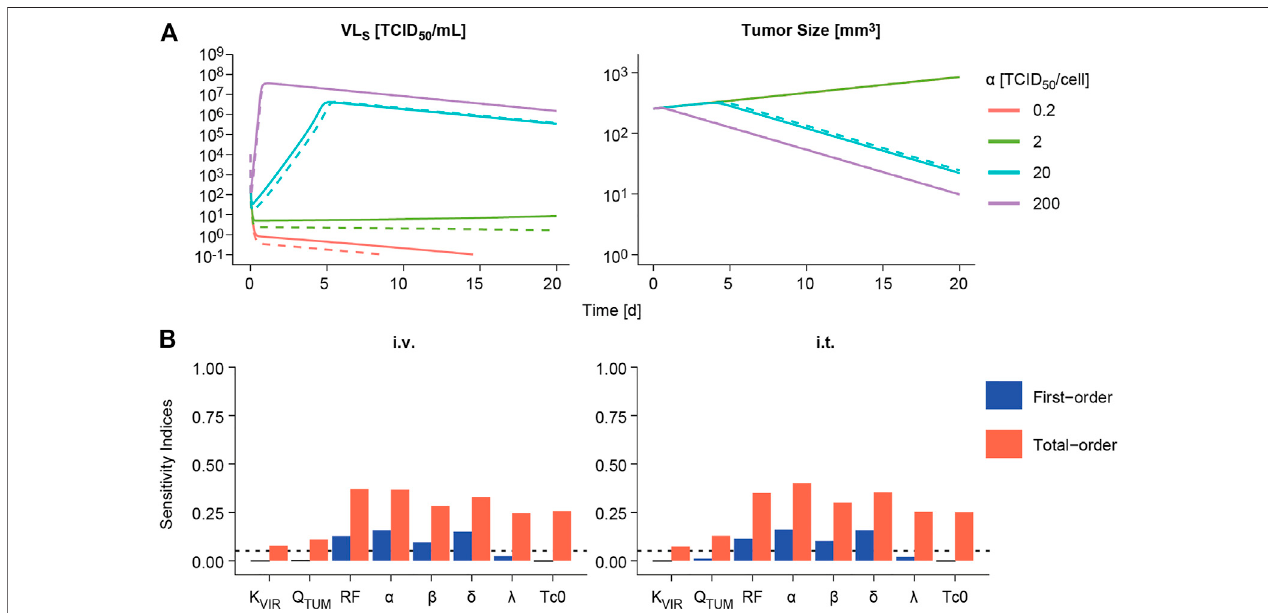
FIGURE 5 | Sensitivity analysis. (A) Impact of varying viral replication ( α ) parameter on the predicted time course of viral concentrations in viral load in serum ( VL S , left panels) and tumor size volume (right panel) following intravenous (dashed line) or intratumoral (solid line) administration of a single V937 dose of 10 4 TCID 50 . (B) . First-order and total-order Sobol ’ s sensitivity indices computed using model predicted tumor size at day 14 following intravenous (i.v.) or intratumoral (i.t.) single administration of a V937 dose of 10 4 TCID 50 .